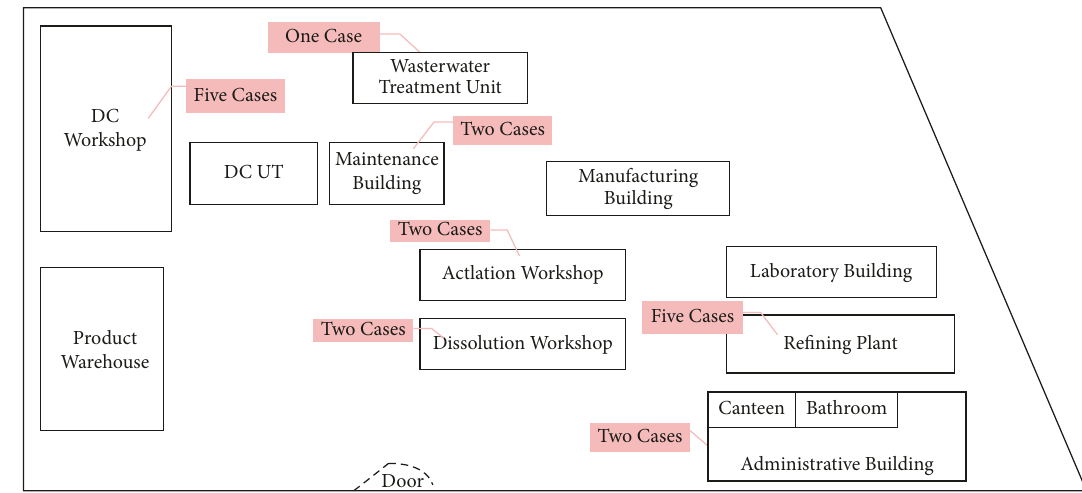
Figure 1: Workshop distribution plan of the